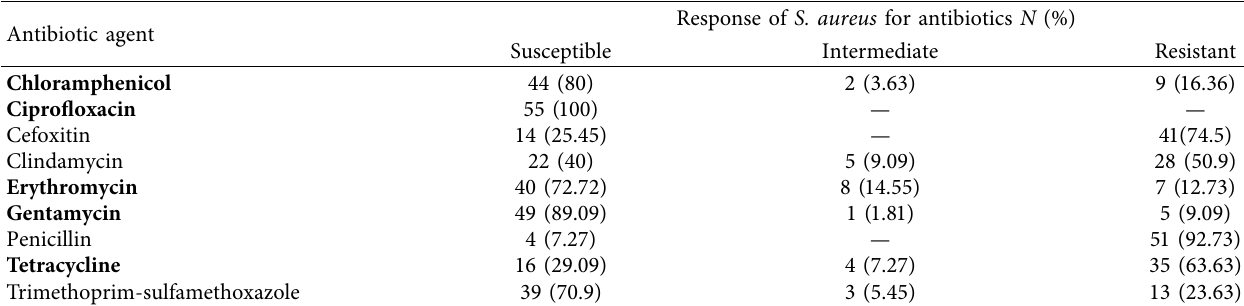
Table 1: Antibiotic susceptibility pattern of S. aureus isolates from the raw beef sample in Bahir Dar city ( N � 55). Antibiotic agent